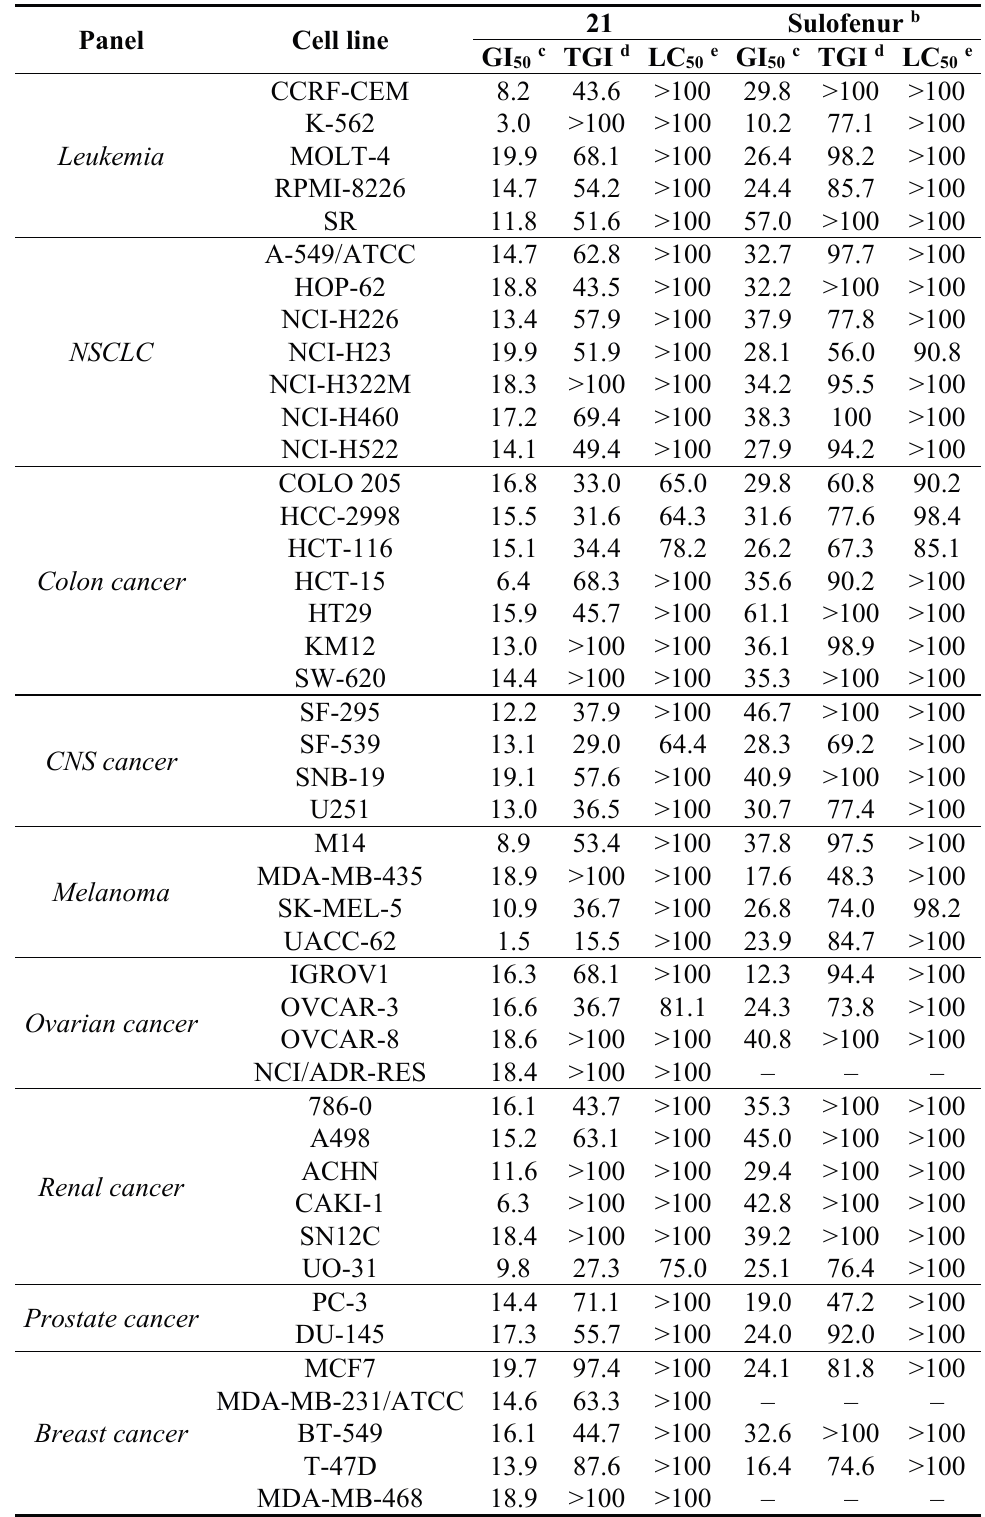
Table 2. Anticancer in vitro data for compound 21 for the most sensitive cell lines (GI 50 < 20 µM) a , and comparative data for sulofenur (NSC-642684) b [30].